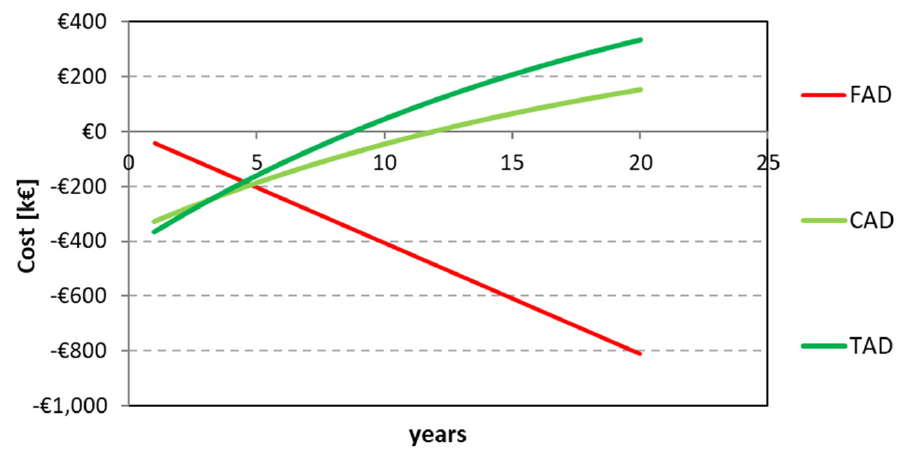
Figure 5. Net present value for the three systems. Table 3. Investment costs and profitability criteria.